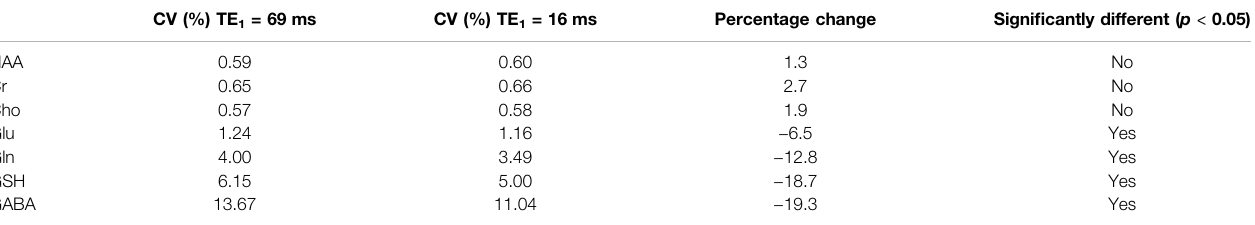
TABLE 3 | Coef fi cient of variation (CV) values of metabolites obtained from Monte Carlo simulations using two different TE 1 values of 69 and 16 ms and the same TE of 106 ms. F-tests were performed to evaluate differences in the variance of metabolite concentrations between the two